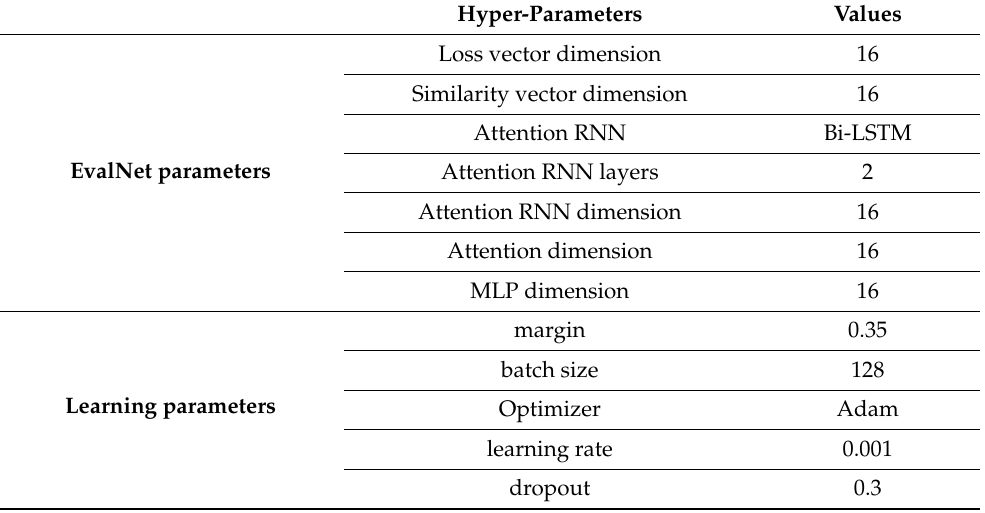
Table 3. Hyper-parameters of